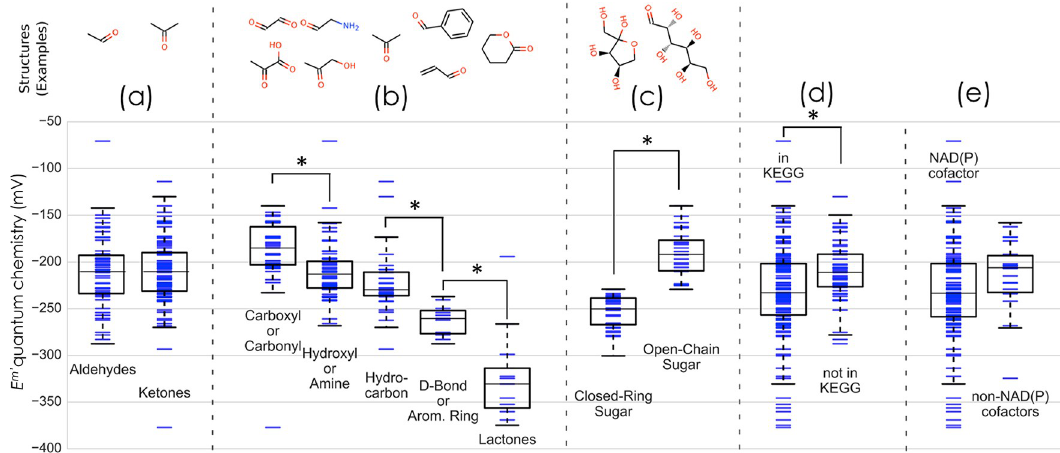
Fig 4. Comparison between the redox potentials of sub-groups for reactions in the G2 category (carbonyl to hydroxycarbon reductions). (A) Aldehydes vs. ketones (non-statistically significant Δ < E 0 m > ); (B) nearest-neighbor functional group (all subgroups have statistically significant Δ < E 0 m > , p < 0.005, except hydroxyl/amine and hydrocarbon) (C) closed-ring sugar reduction to open- chain vs. open-chain sugar reduction to open-chain (statistically significant Δ < E 0 m > , p < 10–5), (D) natural reactions appearing in KEGG vs. non-natural reactions (statistically significant Δ < E 0 m > , p < 0.005) (E) natural reactions that only use NAD(P) as redox cofactor vs. those that use alternative cofactors (cytochromes, FAD, O 2 , or quinones) (non-statistically significant Δ < E 0 m > , p =